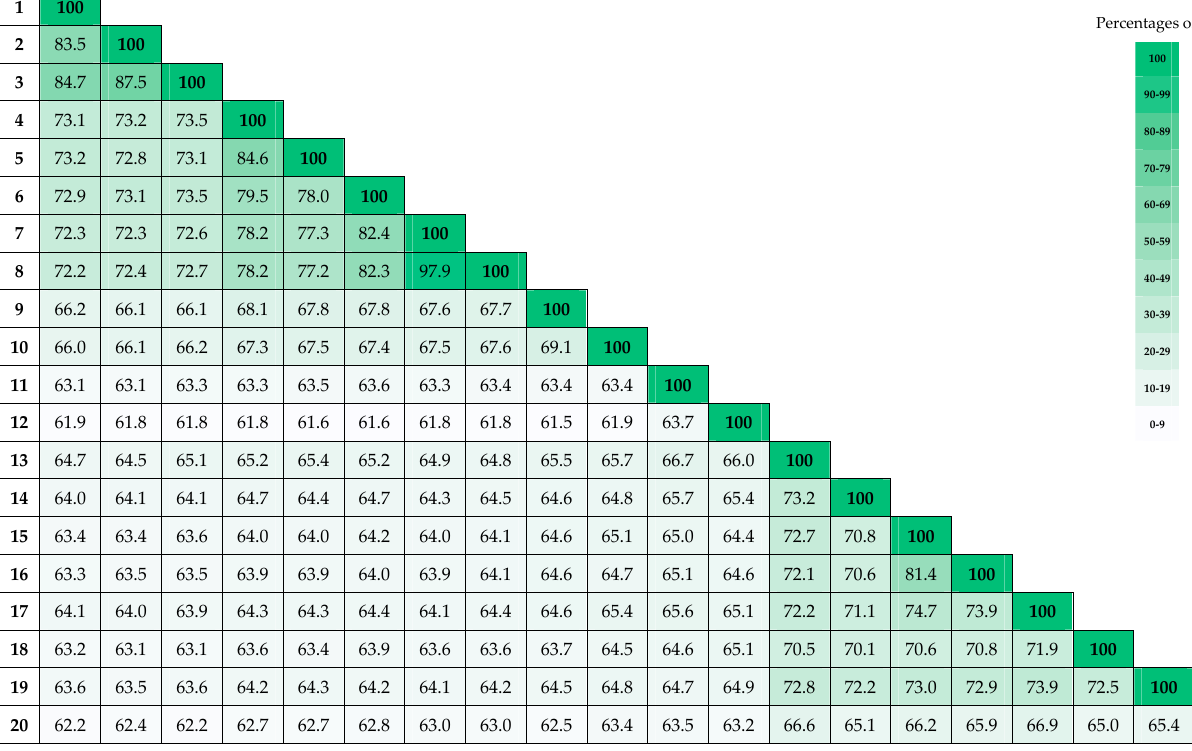
Table 3. Percentages of amino acid identity (AAI) between strain GBPx2 T and members of the family Cyclobacteriaceae.